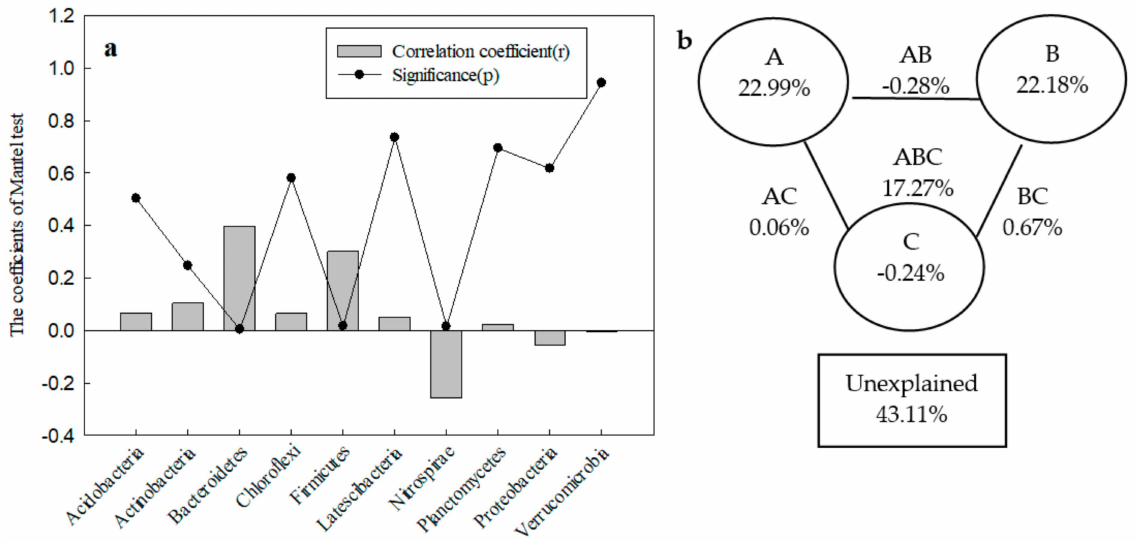
Figure 9. Mantel test ( a ) and variance partition analysis ( b ) between bacterial phyla and soil FAAs dynamics of different fertilization treatments during the rice growth stage. Note: A: Nitrospirae, B: Bacteroidetes, C: